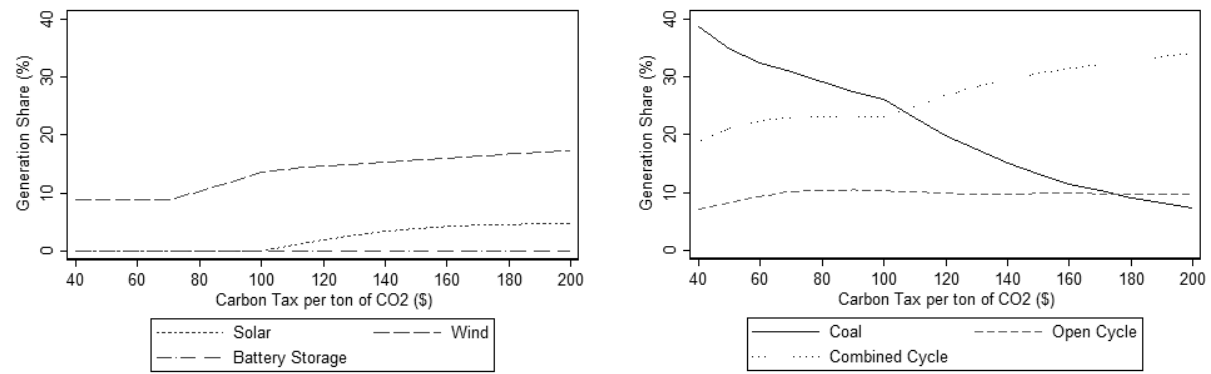
Figure 8. Power generation shares with an increasing carbon.